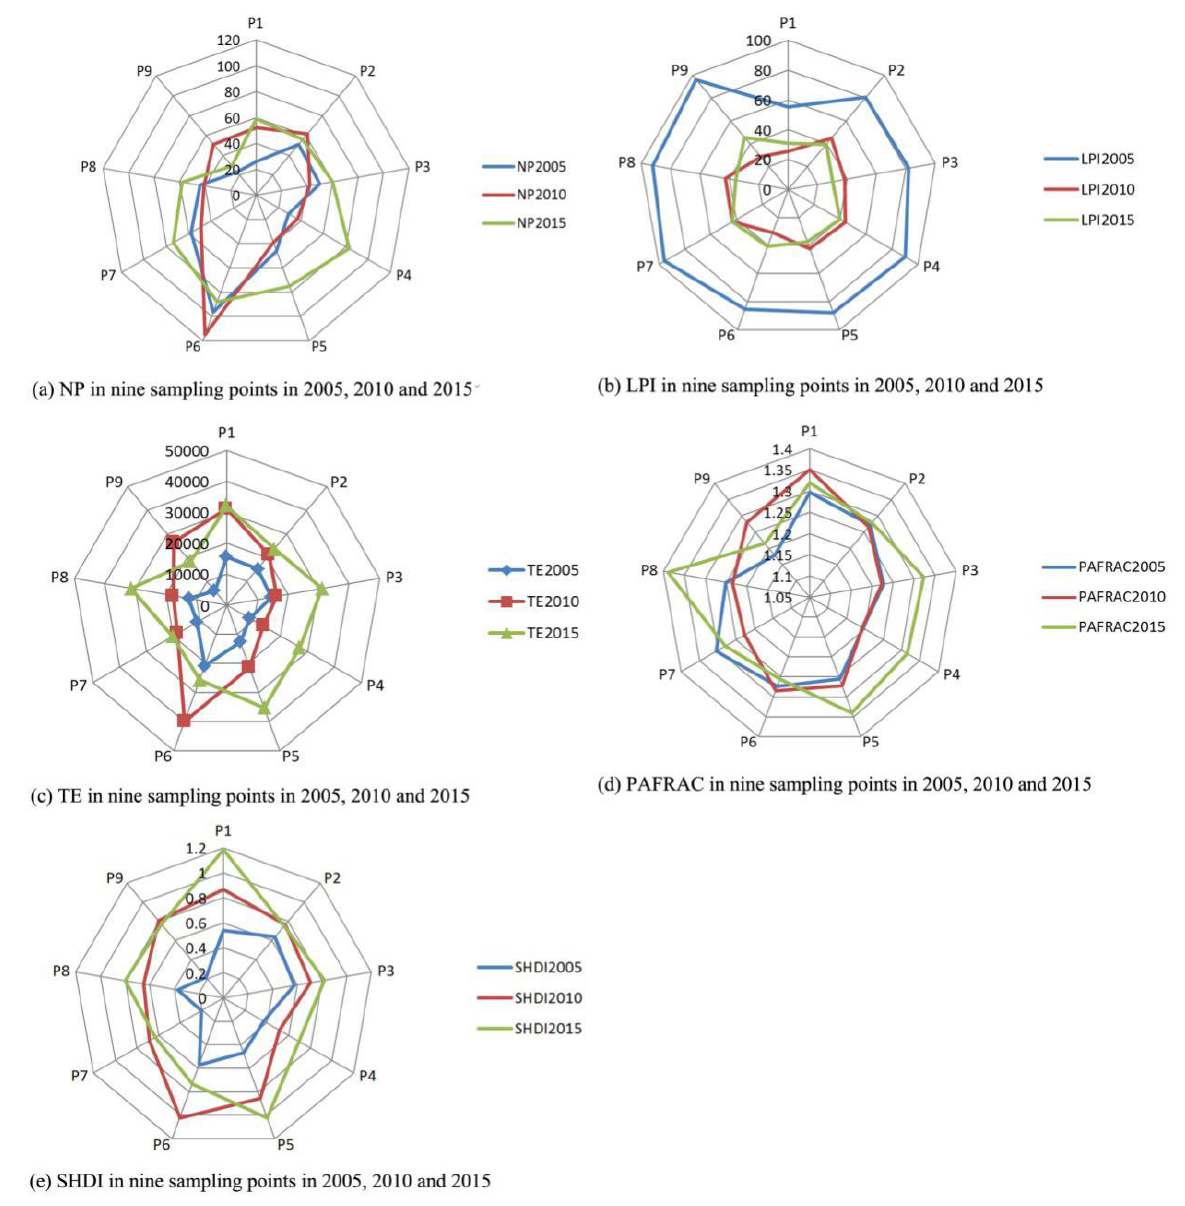
Figure 5. The landscape pattern metrics in nine sampling points in 2005, 2010 and